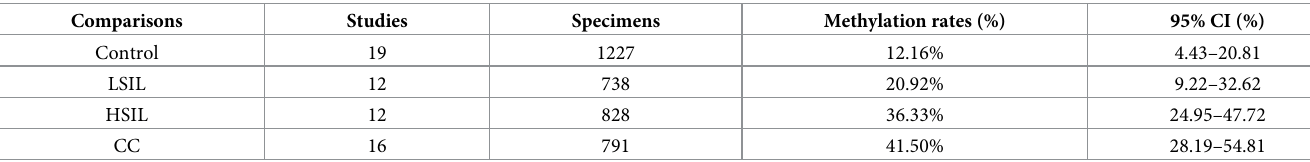
Table 2. Pooled hypermethylation rates of MGMT in LSIL, HSIL and CC